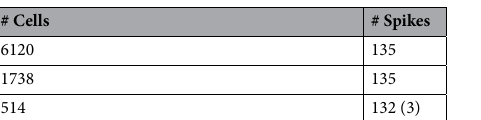
Table 3. The number of spikes and the number of cells in two-dimensional simulations in the domain in Fig. 1a. The spikes were counted throughout the grey matter. Only in the coarsest case did any waves fail to propagate from the unstable region. In that case, only the first three (i parenthesis) spread to the stable parts of the grey matter. The total number of spikes were counted over a 10 s interval.